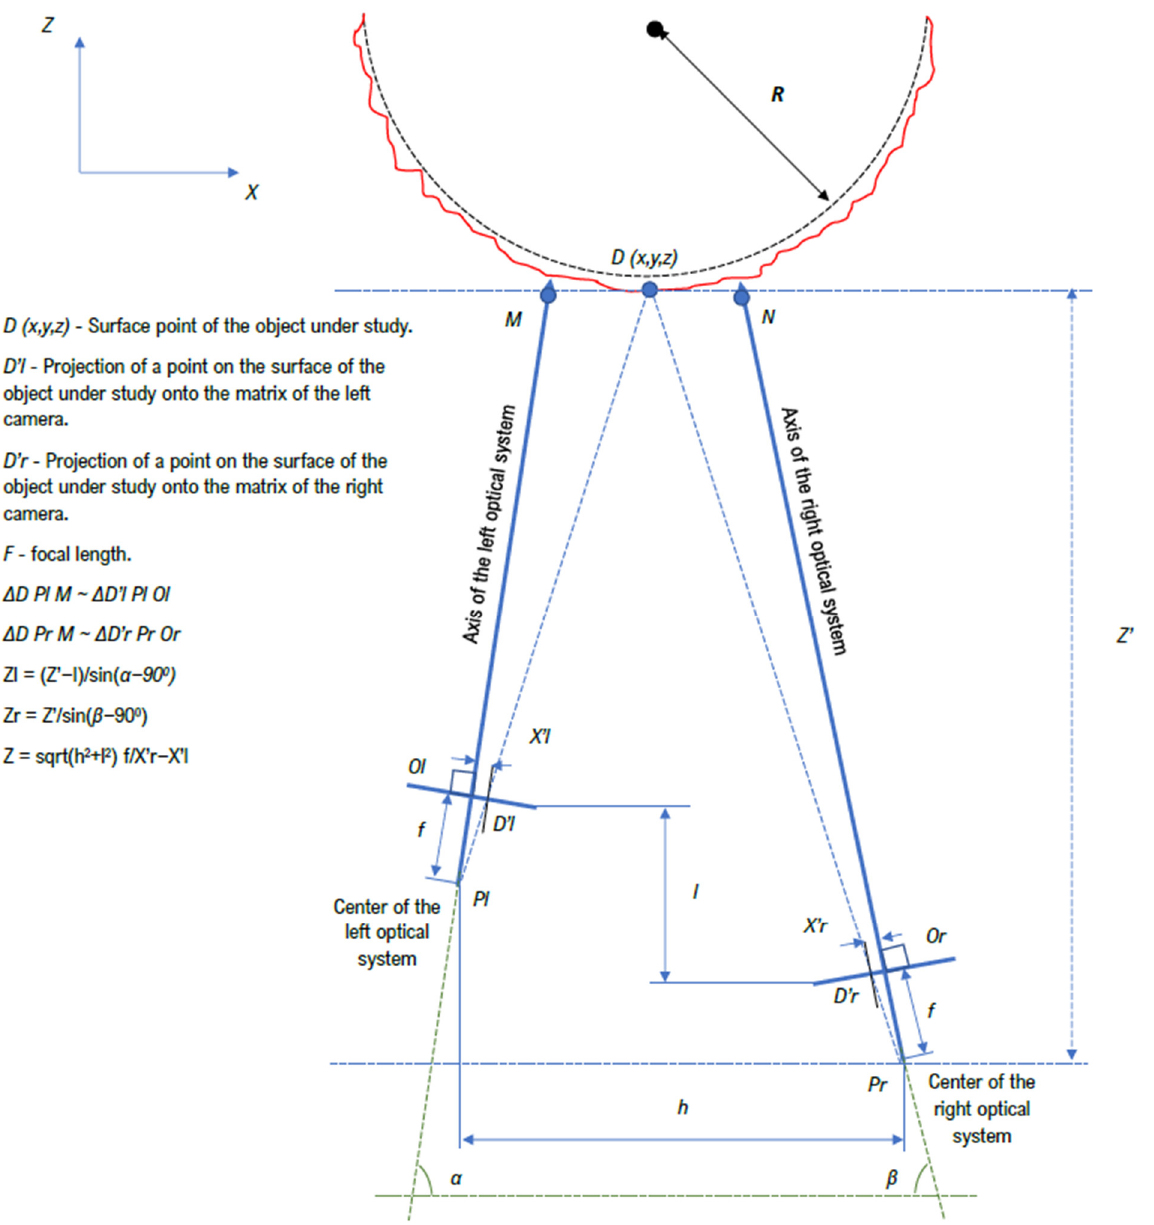
Figure 3. General view of the process of restoring the depth of an object based on a binocular ap-